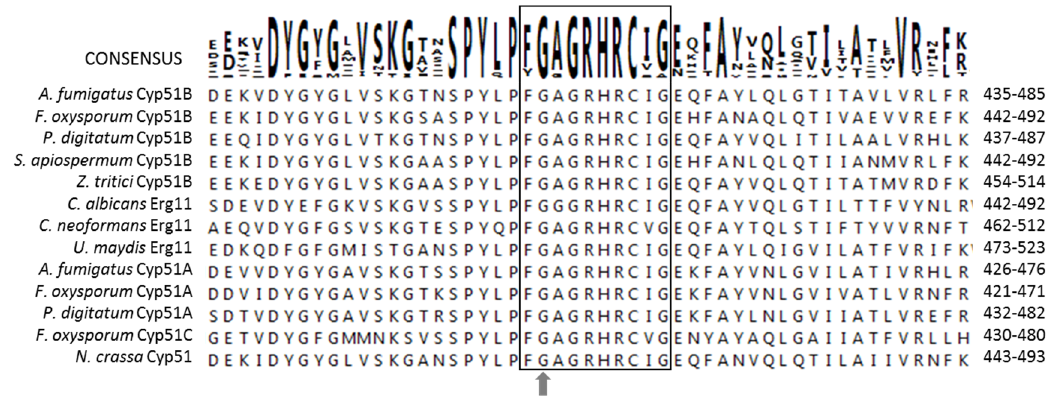
Figure 3. Multialignement of 50 amino acid residues of Cyp51/Erg11 sequences from different